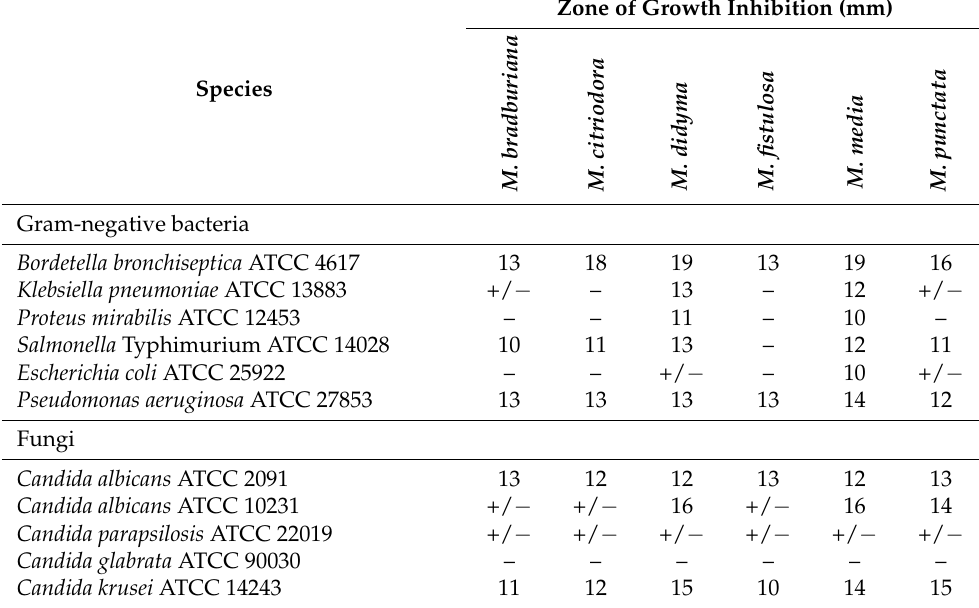
Zone of Growth Inhibition (mm)